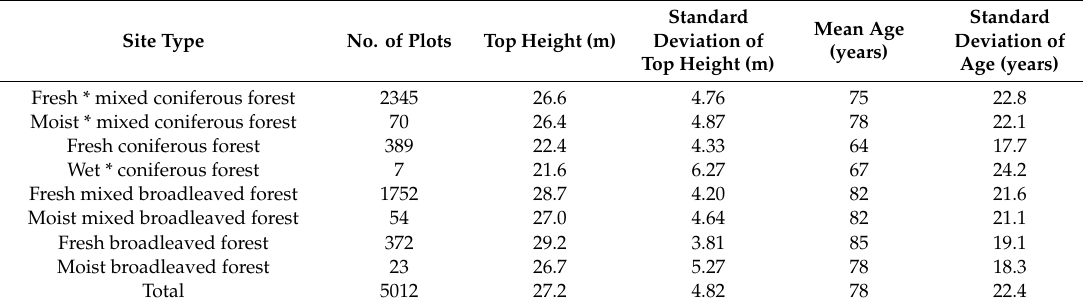
Table 2. The basic characteristics of the research material collected on temporary sample plots located in areas of Scots